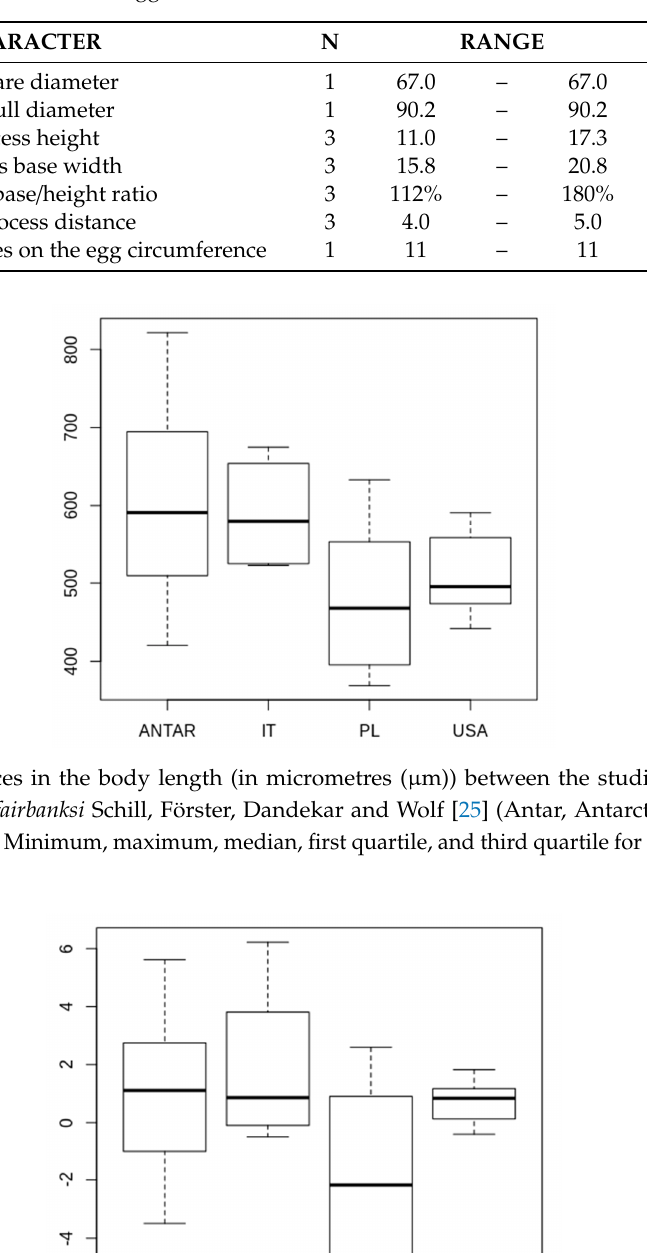
Figure 6. Differences in the buccal tube length (in micrometres ( μ m)) between the studied populations of Paramacrobiotus fairbanksi Schill, Förster, Dandekar and Wolf [25] (Antar, Antarctic; IT, Italy; PL, Poland; USA, USA). Minimum, maximum, median, first quartile, and third quartile for each population are presented.